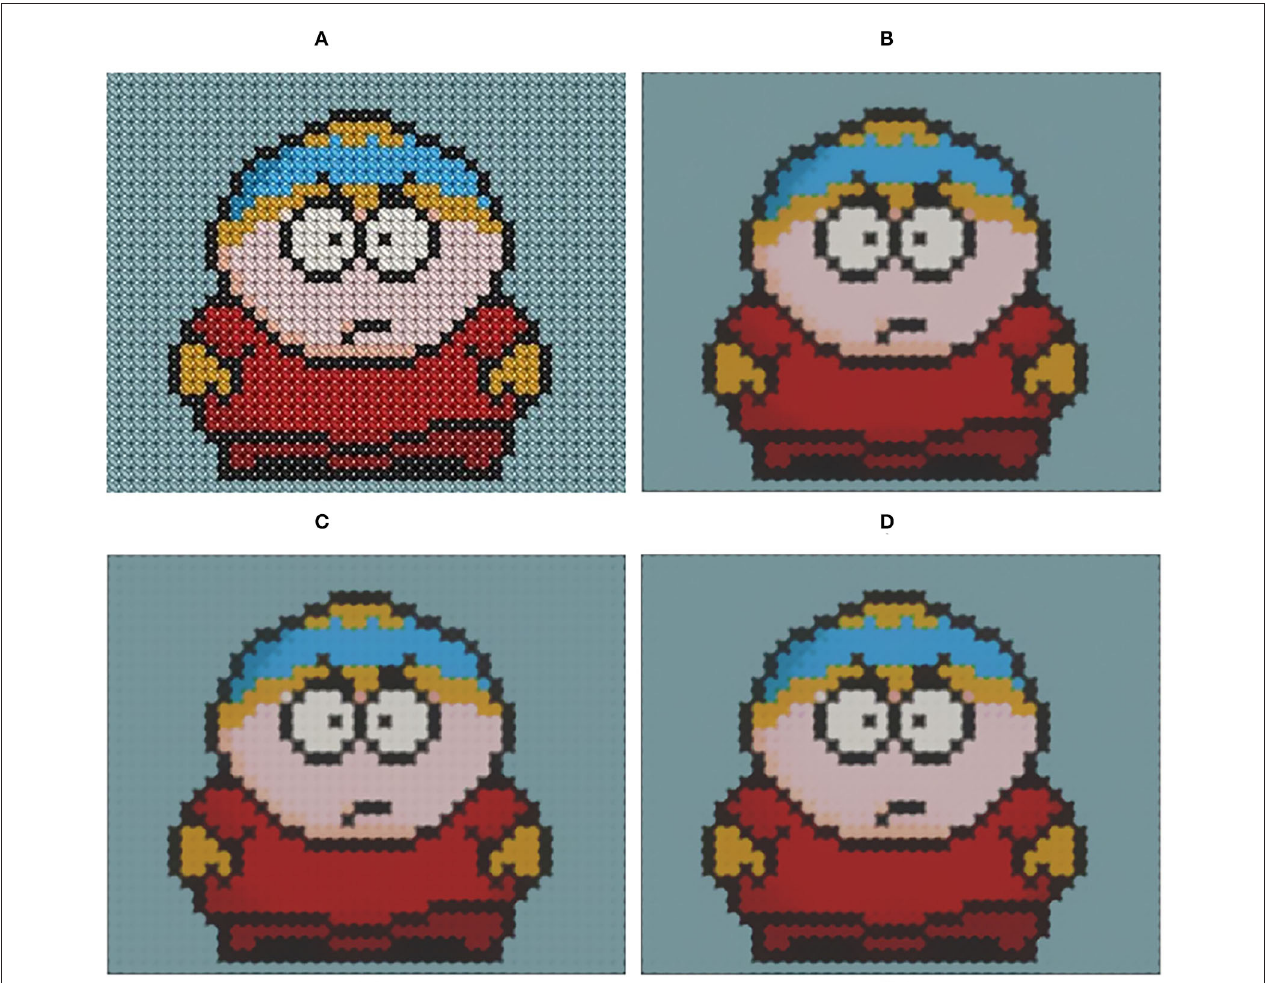
FIGURE 9 | Filtered results using our method. (A) Input image; (B) ( σ r = 25, η = 8, I = 2); (C) ( σ r = 25, η = 12, I = 2); (D) ( σ r = 25, η = 16, I = 2). Reproduced with permission from Li Xu, Qiong Yan, Yang Xia, Jiaya Jia, available at